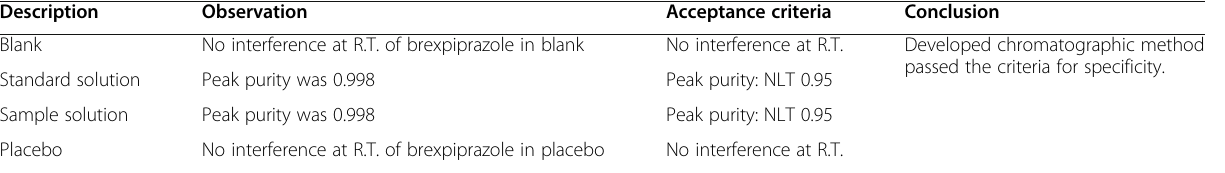
Table 10 Results of specificity